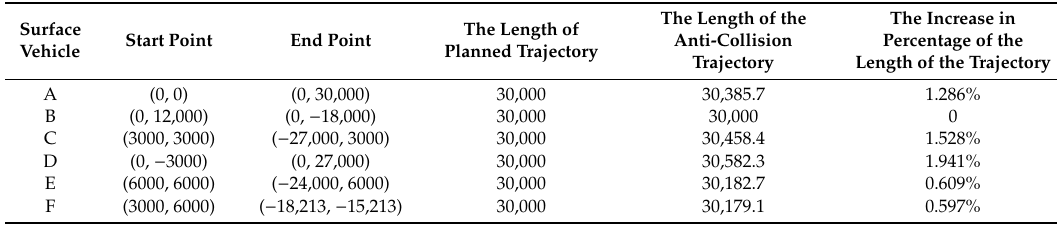
Table 1. Benchmark data for presented